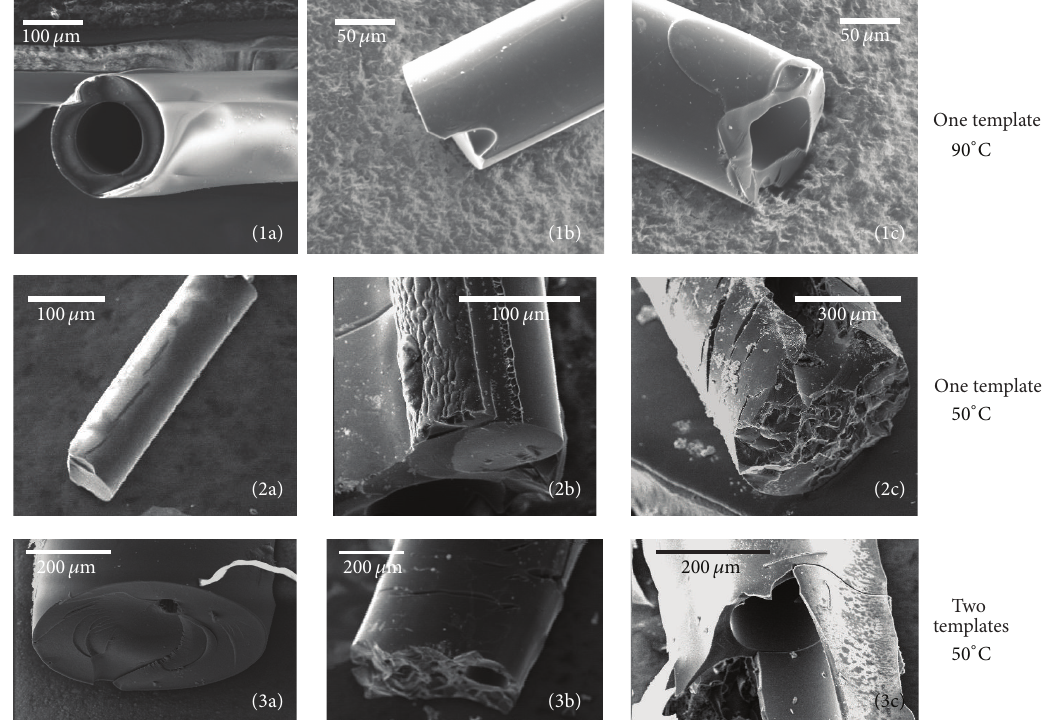
Figure 5: SEM images of (1a) pure SiO 2 -tube (ORMOCER 540); (1b) porous carbon tubes from ORMOCER 540 and 1 ; (1c) carbon tube from ORMOCER 1051 and 1 . SEM images of carbon rods from 1 and (2a) ORMOCER 540, (2b) ORMOCER 1051, and (2c) a glass capillary. SEM images of porous carbon tubes, synthesized using a glass capillary as outer template and (3a) glass fibre, (3b) ORMOCER 540, and (3c) ORMOCER 1051 as inner